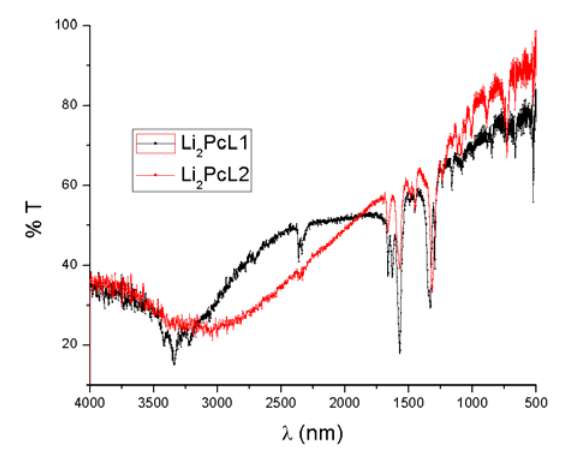
PcL1 and Li 2 2